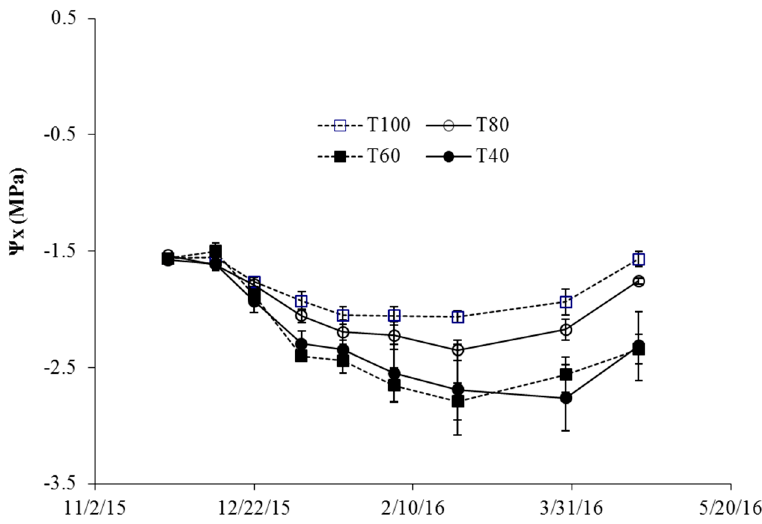
Figure 16. Changes in midday stem water potential ( Ψ x ) in the 2015–2016 seasons. Each point represents the average of the measurements; the vertical bars represent the standard error.